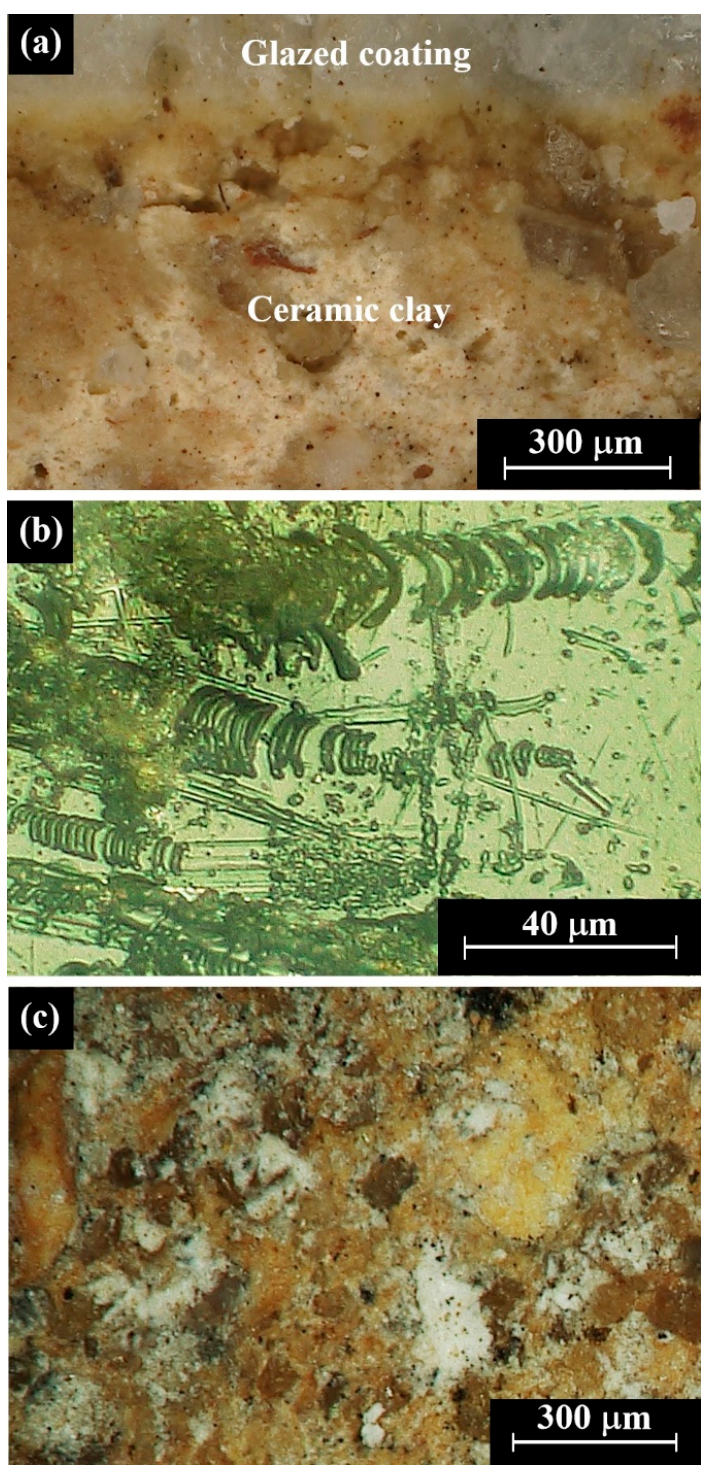
Figure 4. Multifocal light microscopy (LM) images of tiles. ( a ) Tile no. 334 (Type A): clay body and white glaze layer on top; ( b ) creep deformation and chatter mark trails in white glaze layer; and ( c ) tile no. 328, Type B: clay body (back of tile, area of brown clay body).